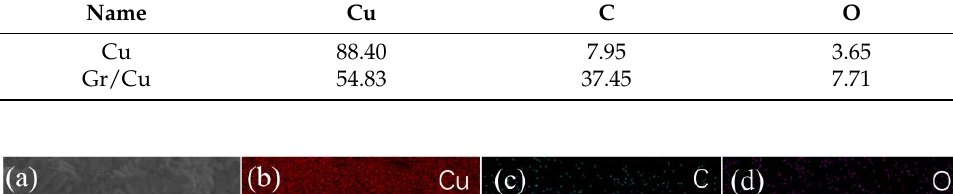
Figure 3. SEM images and EDS of the samples. ( a ) GO, ( b ) pure Cu, ( c ) low magnification and ( d ) high magnification of the Cu-Gr, EDS of the ( e ) Cu and ( f ) Cu-Gr. Table 1. Proportion(at%) of EDS elements.